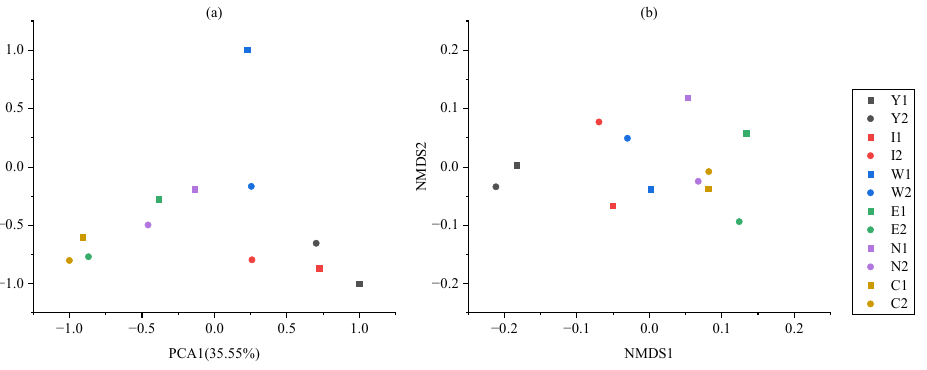
Figure 5. PCA and NMDS analysis of each sample in the Heidaigou open-pit coal mine dump and control area. ( a ) is PCA, ( b ) is NMDS.